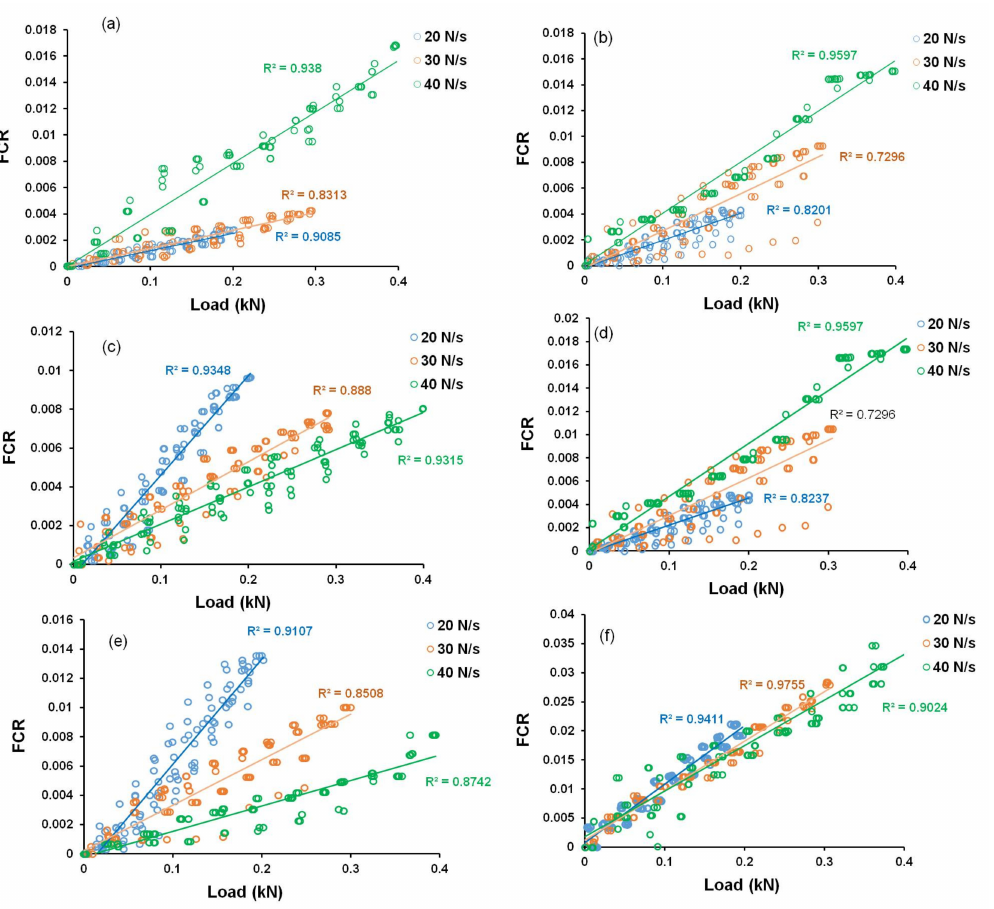
Figure 17. FCR-load correlation of CNF-based hybrid cementitious composites: ( a ) 0.25% CF + 0.1% CNF, ( b ) 0.25% CF + 0.15% CNF, ( c ) 0.5% CF + 0.1% CNF, ( d ) 0.5% CF + 0.15% CNF, ( e ) 0.75% CF + 0.1% CNF and ( f) 0.75% CF + 0.15%